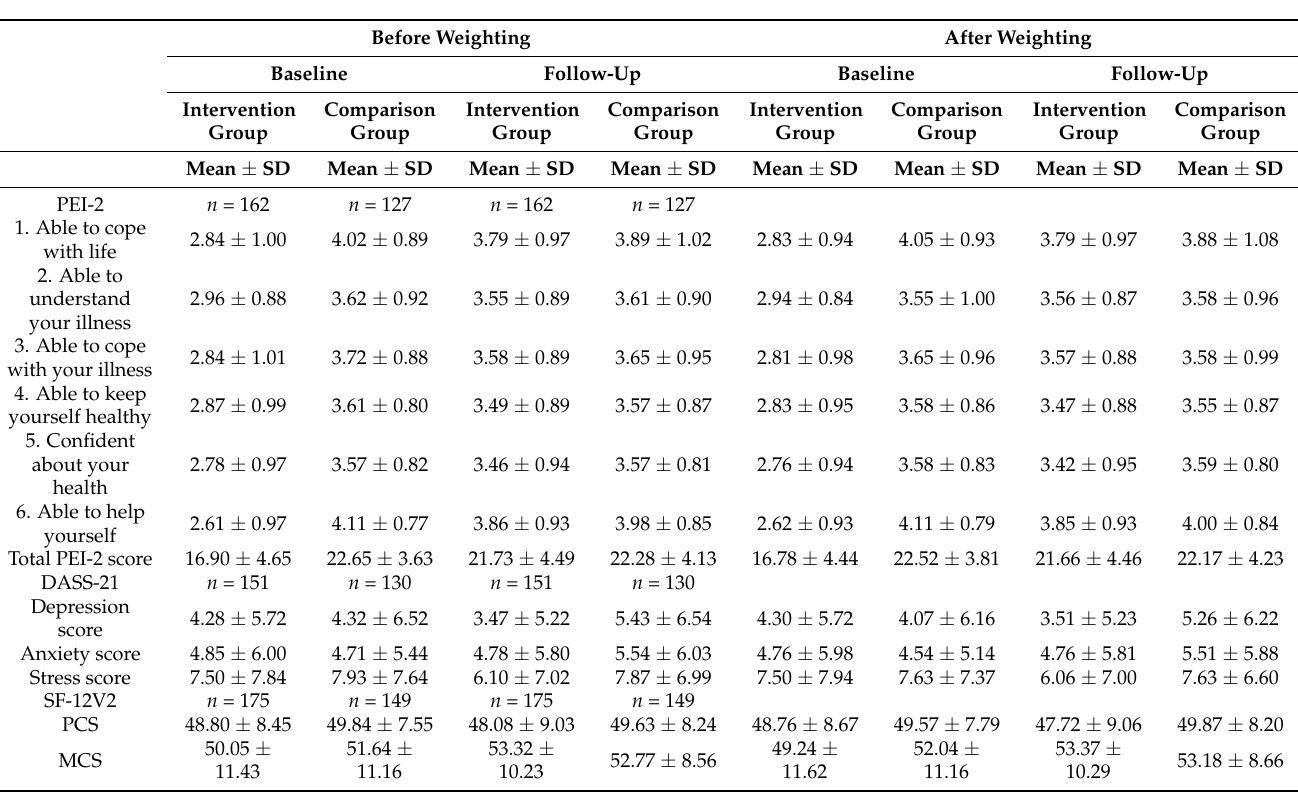
Table 2. Comparison of changes in PEI-2, DASS-21, and SF-12 for intervention and compari- son groups.